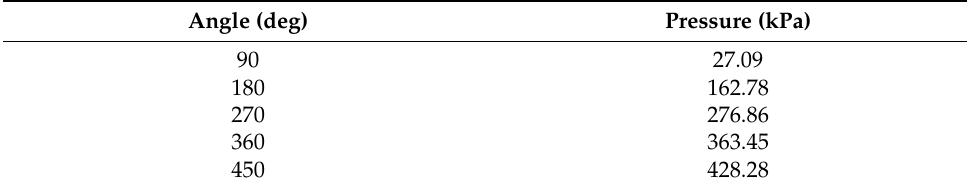
Table 7. Calculated pressure created by rotation of roller screw mechanism onto load cell .